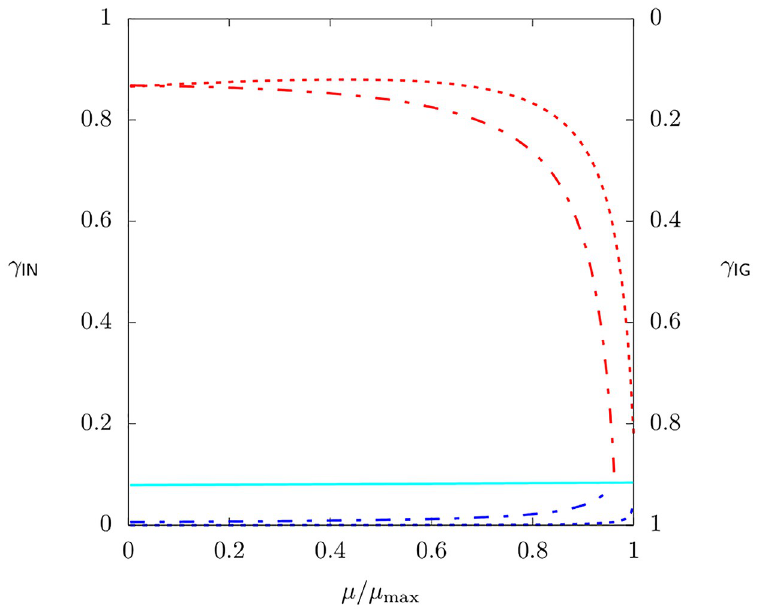
Fig 2. Relative contribution of ammonium uptake to growth, γ (for the small model of a self-fabricating cell). Note that γ IG = 1 − γ IN . Colors correspond to classes of EGVs described in the main text.